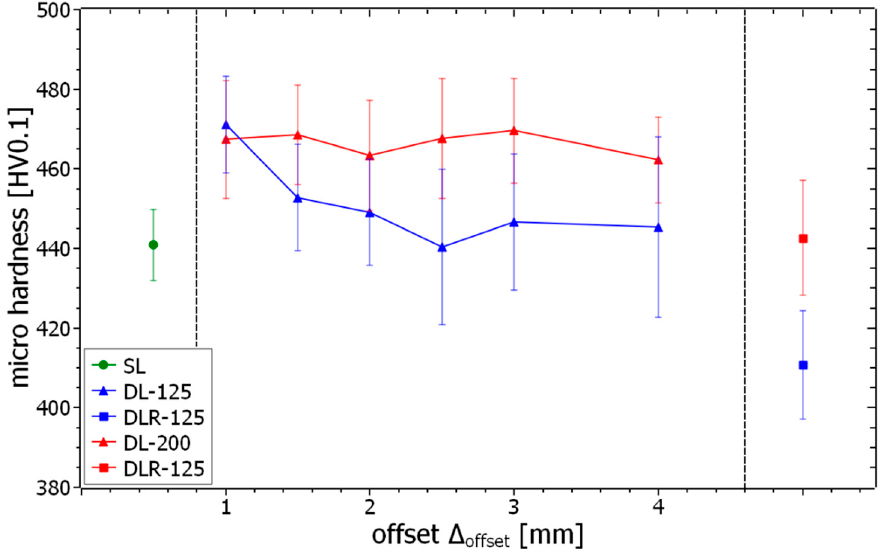
Figure 14. Measured microhardness values of the samples produced with the different process parameter sets.